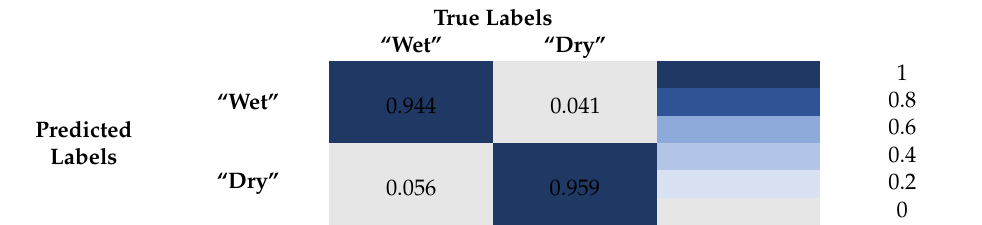
Table 3. Confusion matrix for test set 2 when results were compared with manually assigned